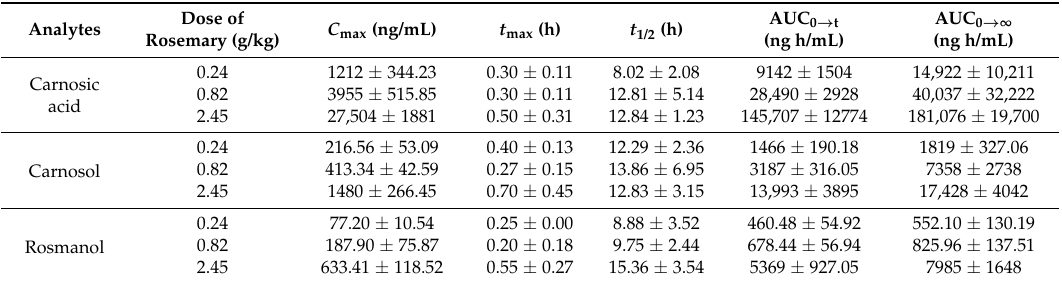
Table 6. Pharmacokinetic parameters of three diterpenes after oral administration of R. officinalis extract at doses of 0.24 g/kg ( n = 6), 0.82 g/kg ( n = 6), and 2.45 g/kg ( n = 6) to rats. Dose of Analytes Rosemary